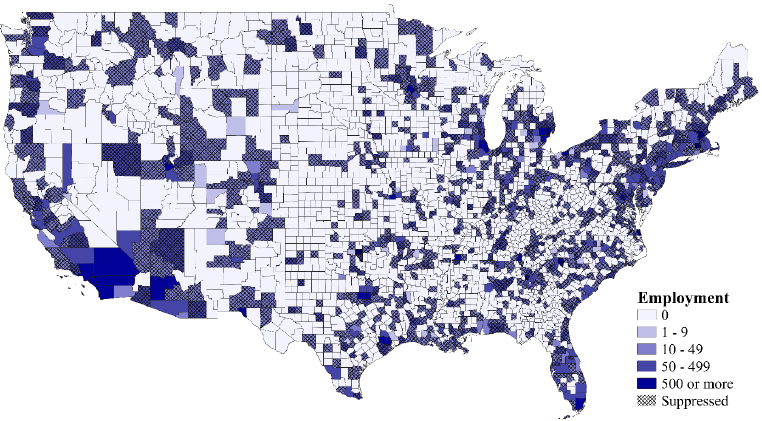
Figure A.5: Employment Distribution of Process, Distribution, & Logistics Consulting (NAICS 541614)